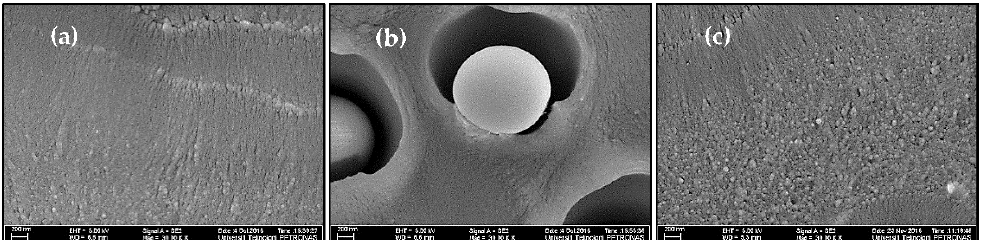
Figure 2. Comparison of the morphology of ( a ) Pure PES membrane (S1), ( b ) PES/unmodified silica MMM (S8), and ( c ) PES/modified silica MMMs (S11) at 30,000×.